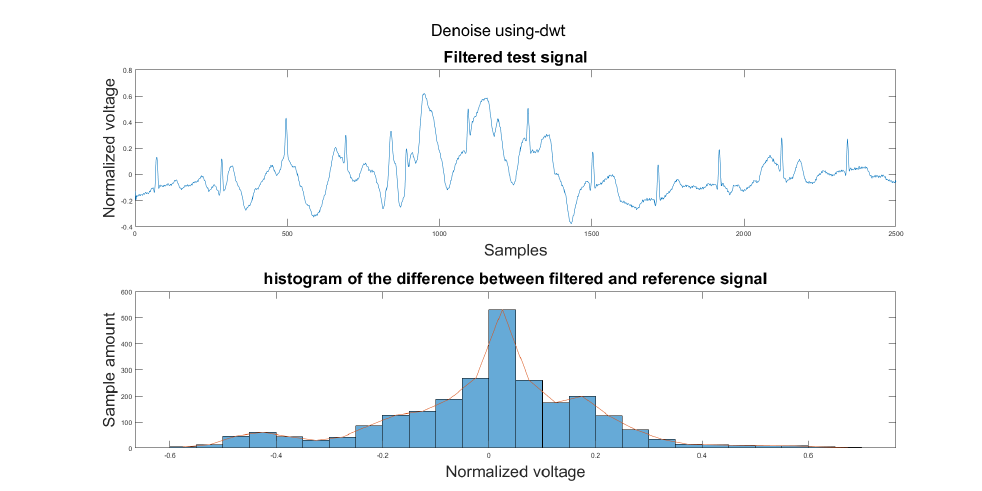
Figure A10. (1) Test signal, (2) histogram of the difference.